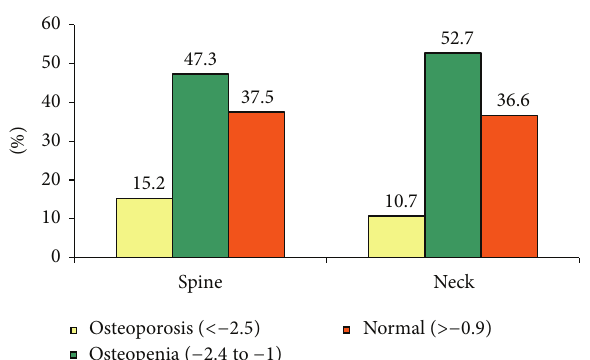
Figure 1: Showing categorization of BMD in the study